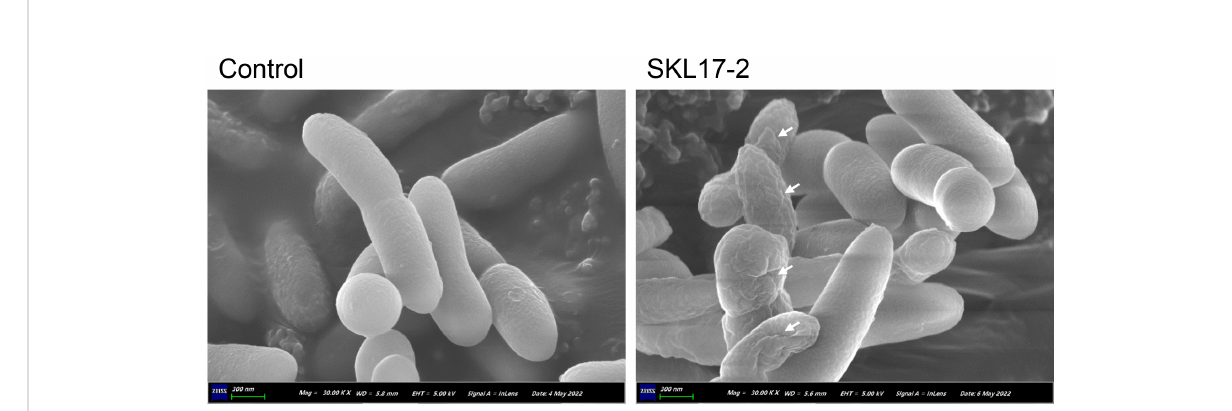
FIGURE 8 Scanning electron microscopy images of P. plecoglossicida treated for 2 h at 28°C with 4 m M SKL17-2 or 10 mM PBS (control). Following that, the bacteria were fi xed and collected on polycarbonate fi lters. After dehydration and vacuum drying, fi lters with bacteria were placed onto aluminum stubs, coated with gold, and examined under scanning electron microscope. Scale bars, 300